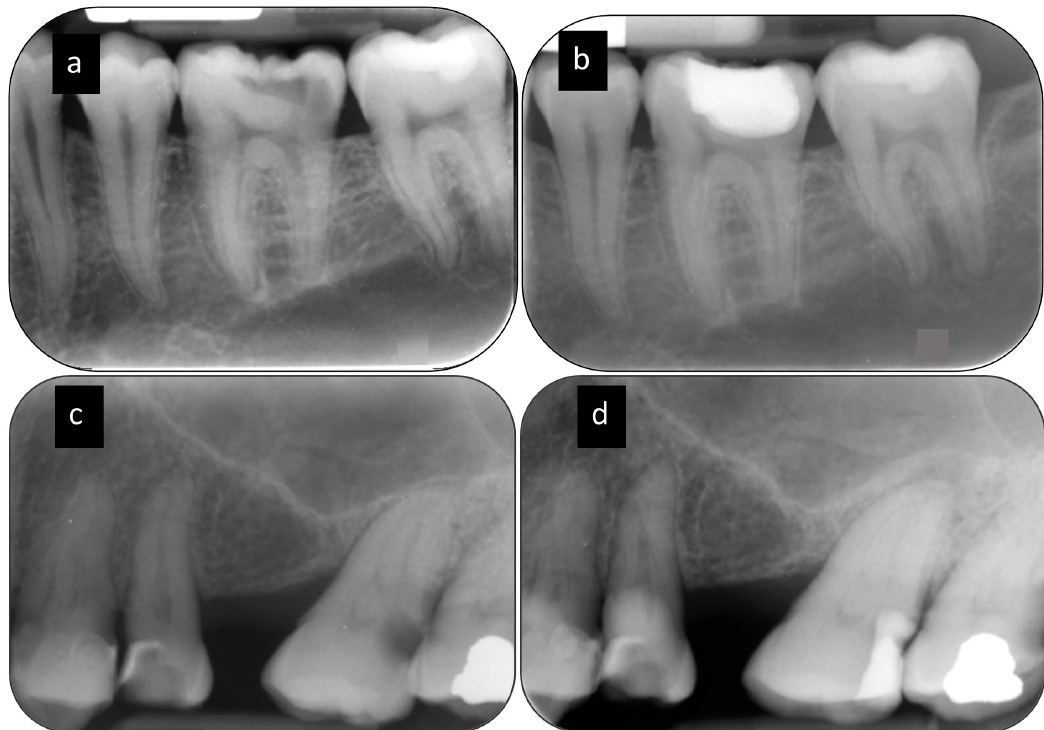
Figure 2. Periapical radiolucency detected by PA radiograph. ( a ) Periapical radiograph of the lower left first molar with a healthy PDL space at T0 ( b ) T24 PA radiograph shows healthy periapical tissue. ( c ) Periapical radiograph of the upper left second molar with a healthy PDL space at T0 ( d ) T24 PA radiograph shows at the periapex of the tooth a periapical